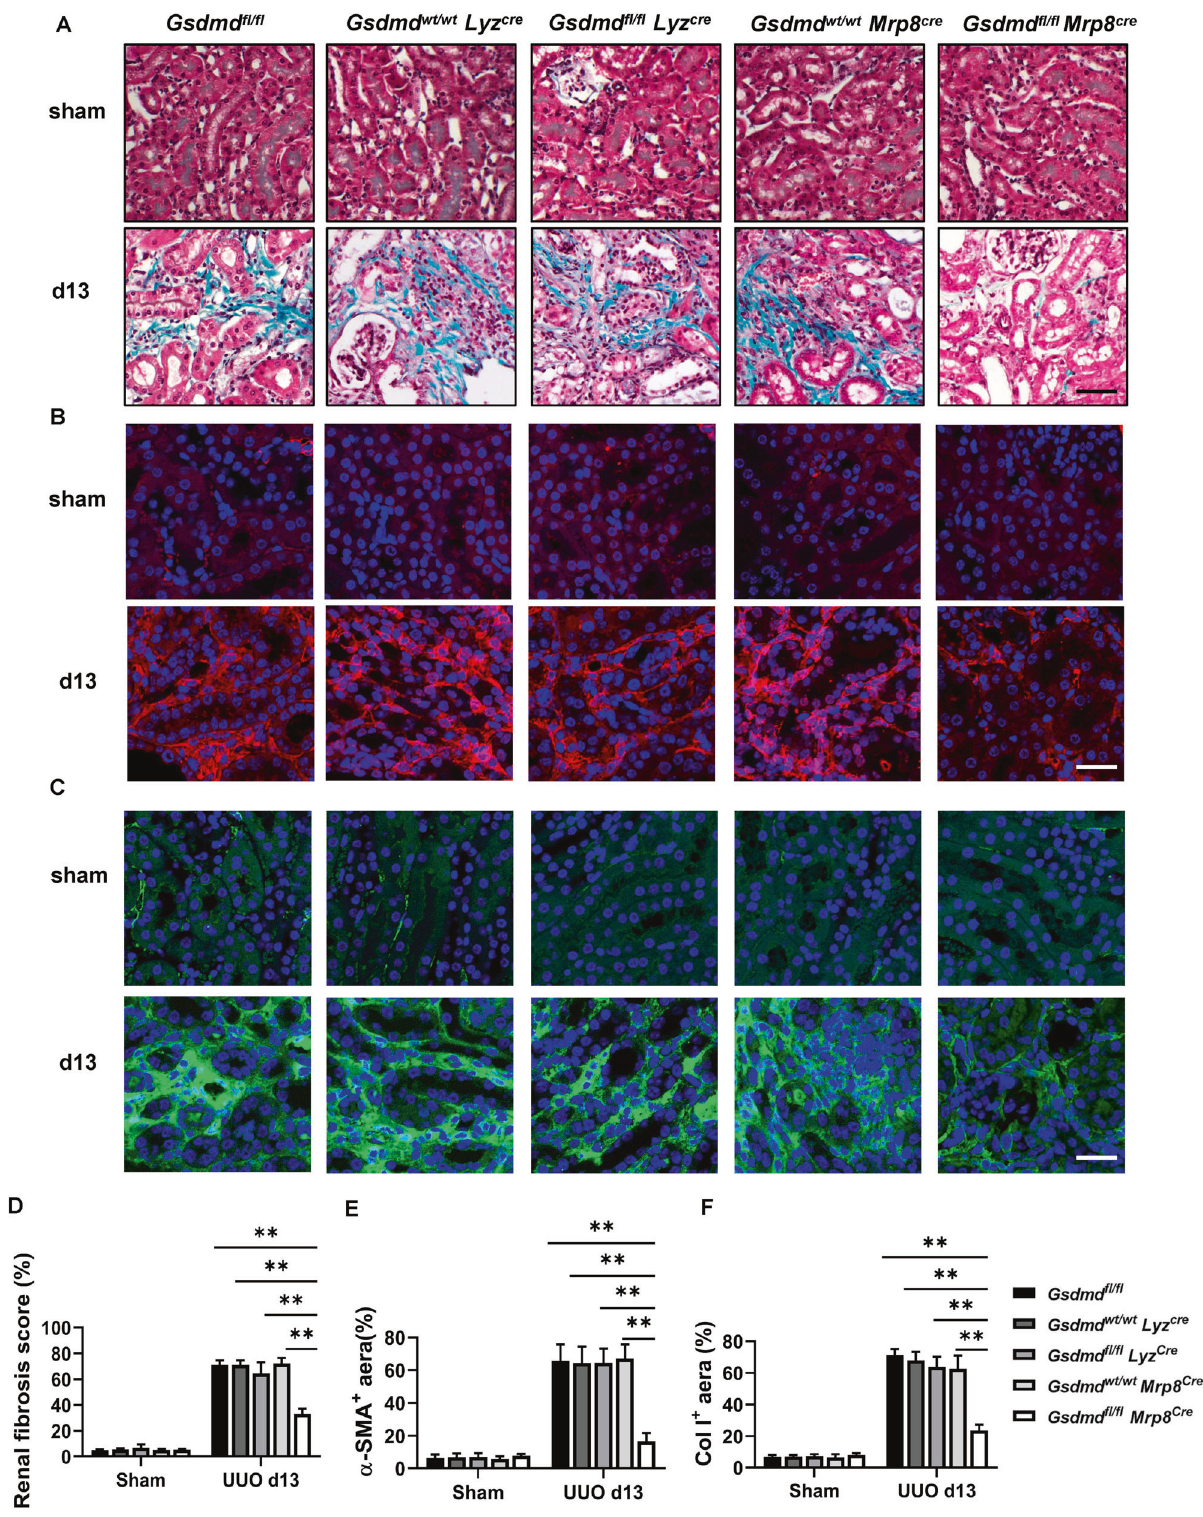
Fig. 6 Speci fi c deletion of Gsdmd in neutrophils instead of macrophages protected the kidney from undergoing fi brosis after UUO. A Representative images of Masson trichrome staining of kidney sections. Kidneys were collected from Gsdmd fl / fl , Gsdmd wt/wt Lyz cre , Gsdmd fl / fl Lyz cre , Gsdmd wt/wt Mpr8 cre and Gsdmd fl / fl Mpr8 cre mice on day 13 after UUO. Scale bar: 100 μ m. B , C Representative images of immuno fl uorescence staining of kidney sections, showing the expression of α -SMA B and Col I C . DAPI (blue) was used for nuclear staining. Scale bar: 100 μ m. D – F Quanti fi cation of renal fi brosis scores evaluated by Masson trichrome staining D , α -SMA E , and Col I F expression by immuno fl uorescence. n = 6. ** P < 0.01.